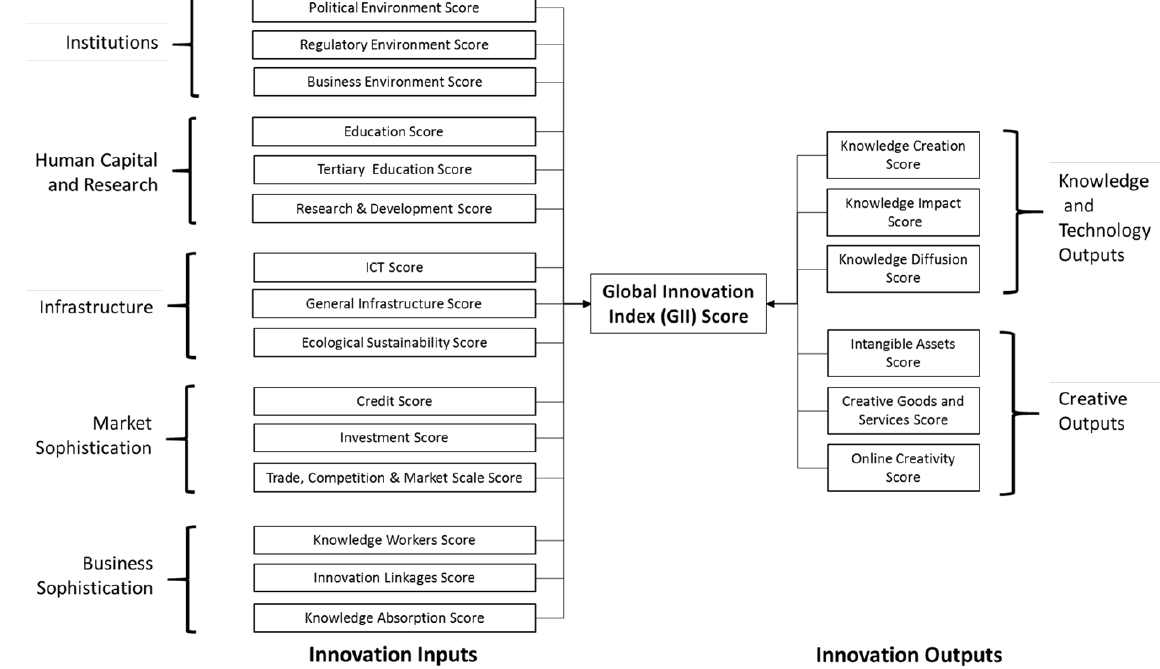
Fig. 1. Drivers of Innovation Research Model after Dutta et al. 2016 The change in GII score is the dependent variable and changes in those innovation inputs or outputs that were statistically significantly correlated to GII are the independent variables. In addition, we wish to further examine any innovation inputs or outputs that might influence the predictive variables by identifying any statistically significant correlations between them. As the GII score is determined using the respective country’s innovation inputs and output scores we are watchful for any collinearities that might exist in the data. Accordingly we will test for multi-collinearity between variables by calculating the variance inflation factor (VIF) in our regressions and employ the Durbin-Watson test on any regression